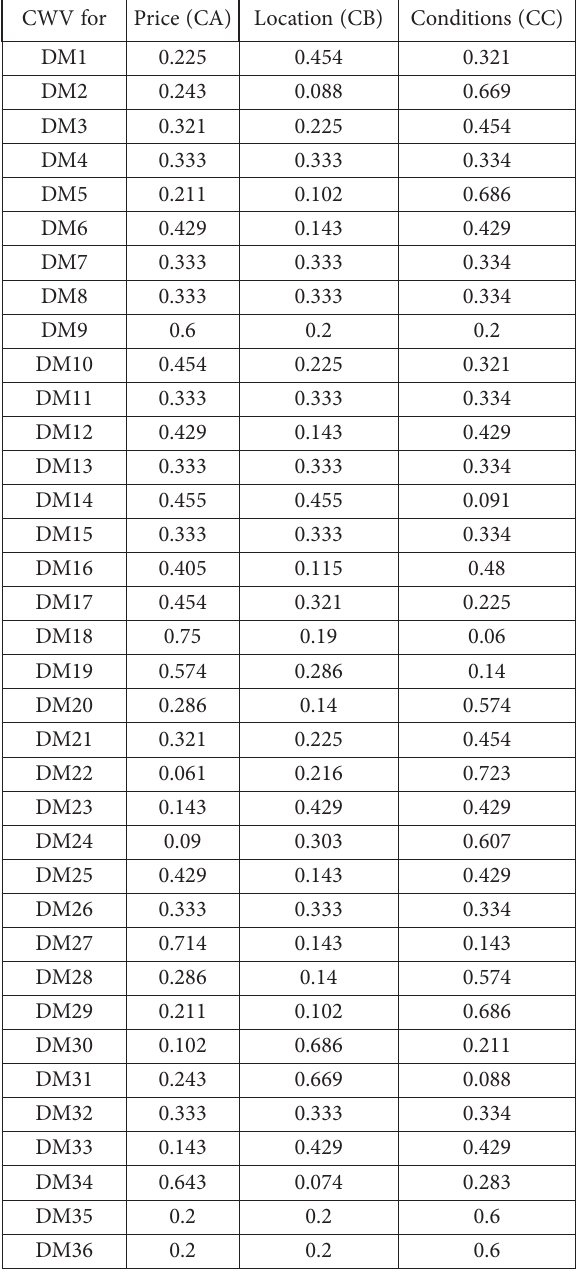
Table 4. Criteria weight values for the decision makers whose pairwise comparison matrix for the constructs that passed the consistency